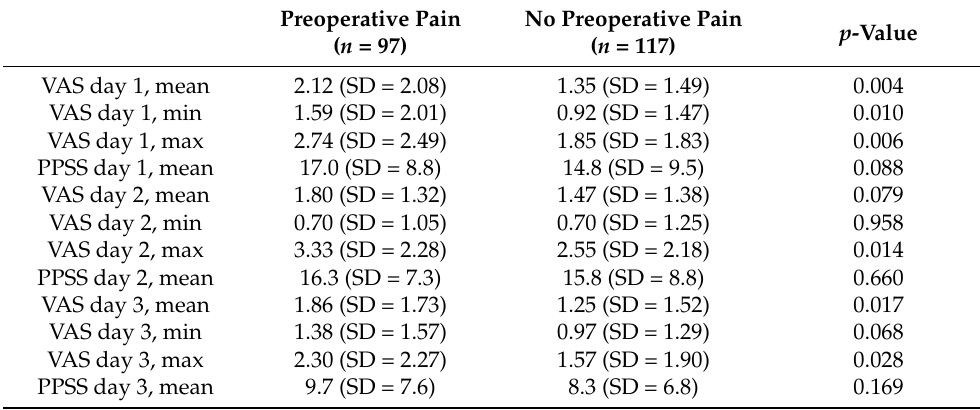
Figure 1. Comparison of the mean postoperative VAS scores during the day of the operation between patients with and without pain before the surgery ( p -value = 0.004). Similar results apply for the minimum ( p -value = 0.01) and maximum ( p -value = 0.006) VAS scores. Table 4. Comparison of postoperative pain between groups with and without pain before